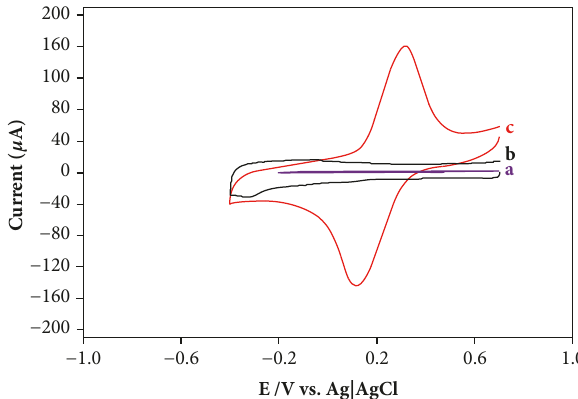
Figure 9: The CV curves of the electrode. (a) CA/CC. (b) CNTs/CC. (c) CNTs/CA/CC.